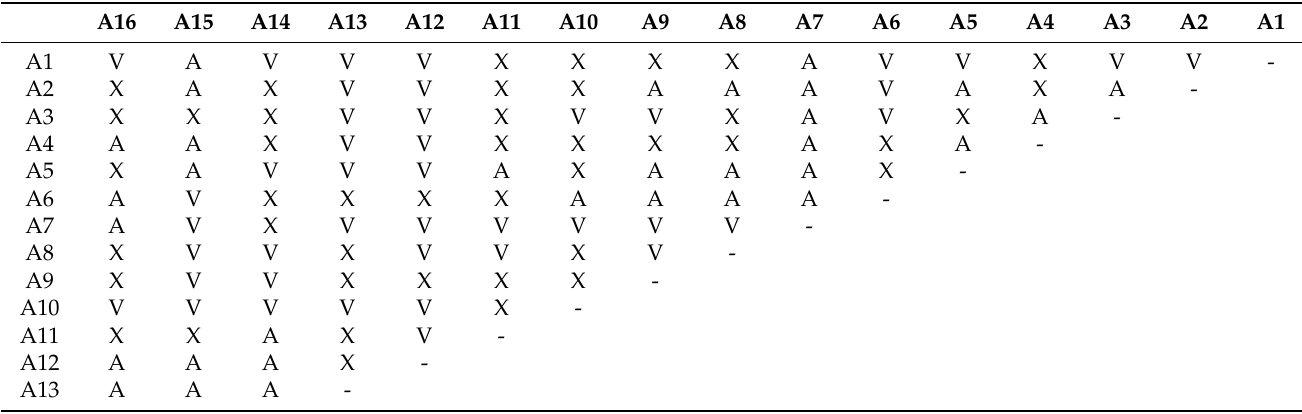
Table 2. Structural self-interaction